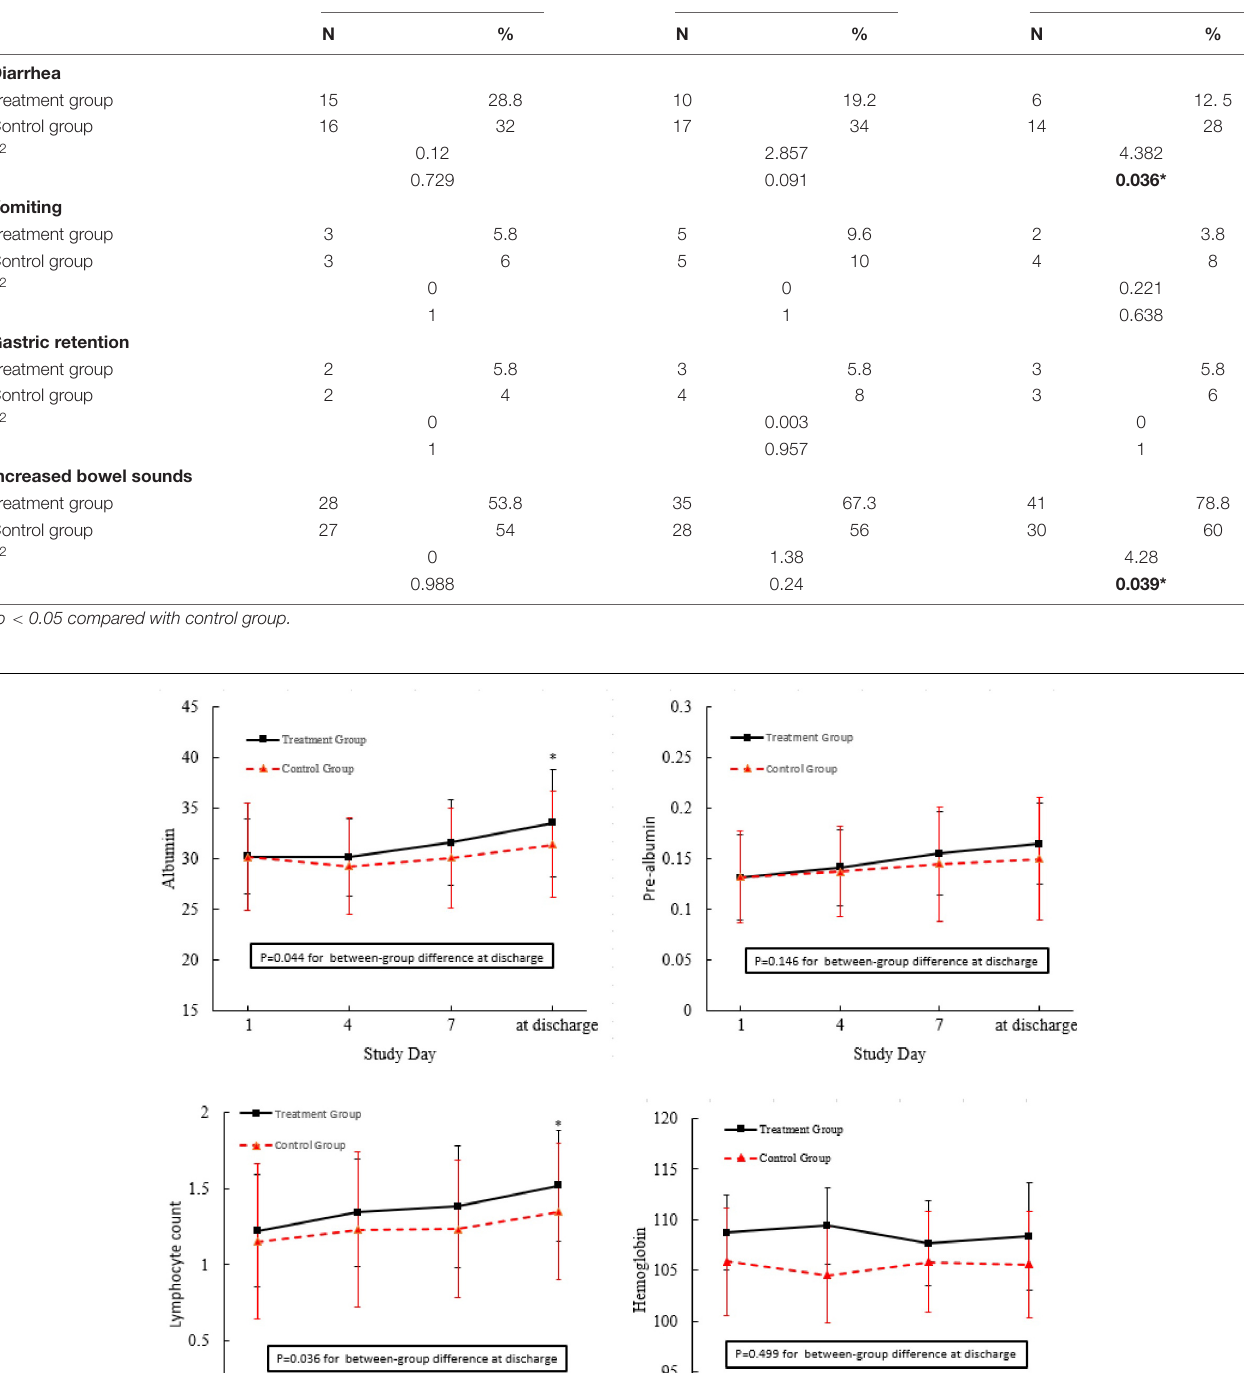
Frontiers in Medicine |